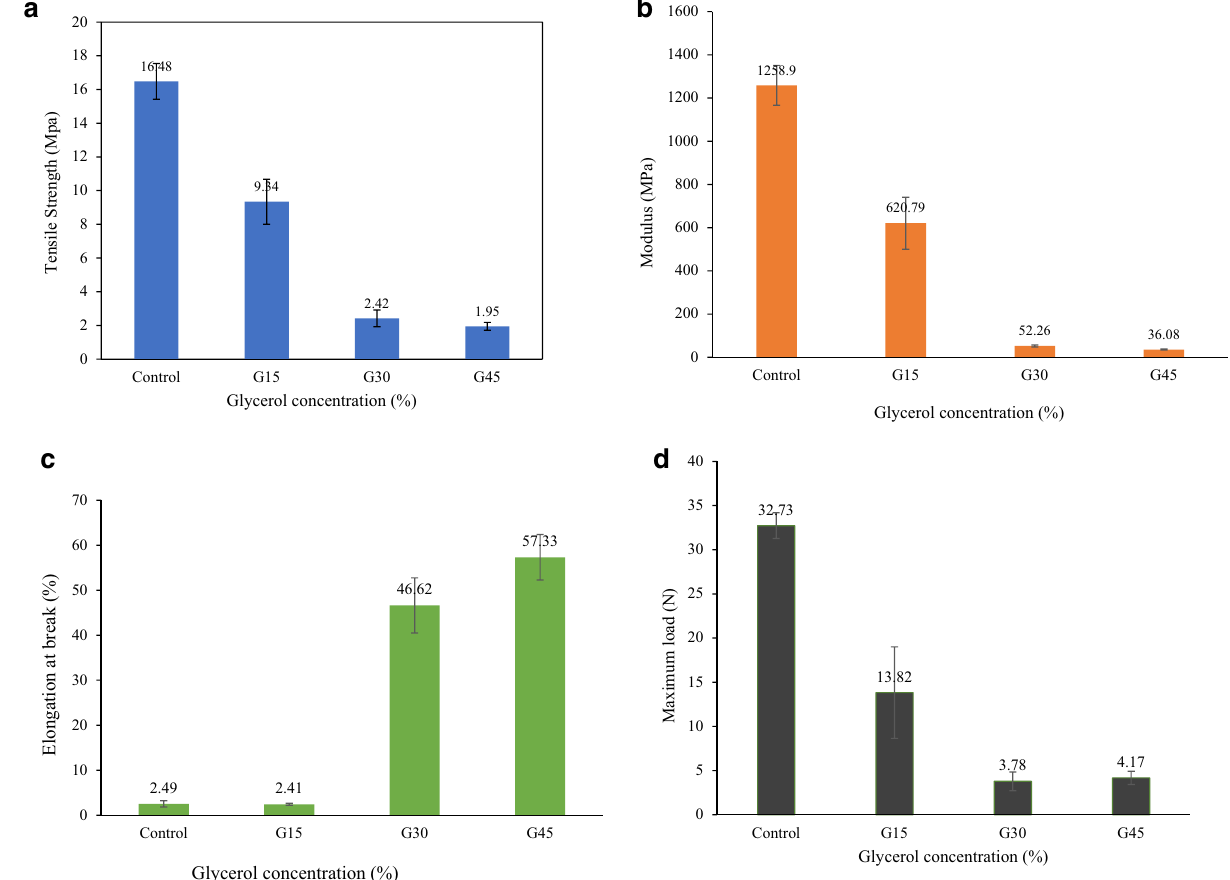
Figure 12. Effect of glycerol concentration on the ( A ) tensile strength, ( B ) tensile modulus, ( C ) elongation at break, and ( D ) maximum load of G-plasticized and control AS